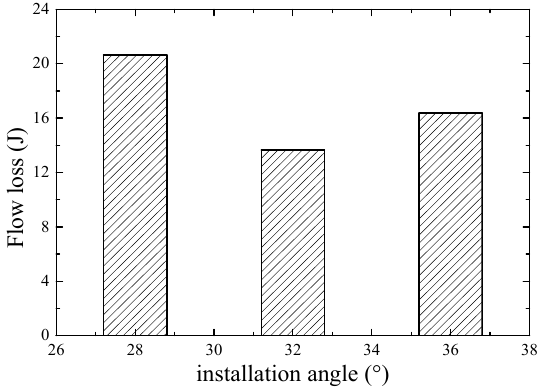
Figure 7. Flow loss at different blade installation angle with blade number 22.